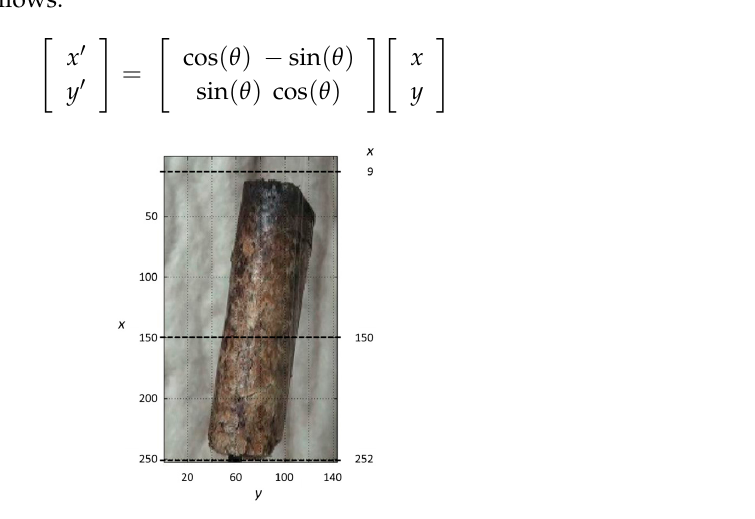
Figure 1. Image file of a wood pellet in gasification mode and lines of x = 9, 150 and 252.